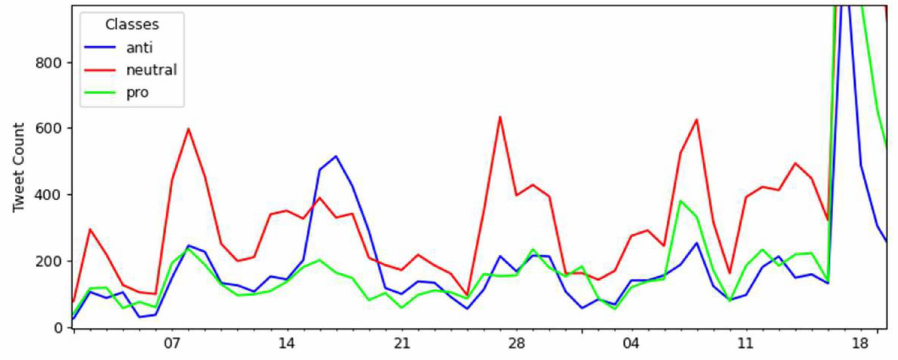
Figure 9. Details of the interval between December 2020 and January